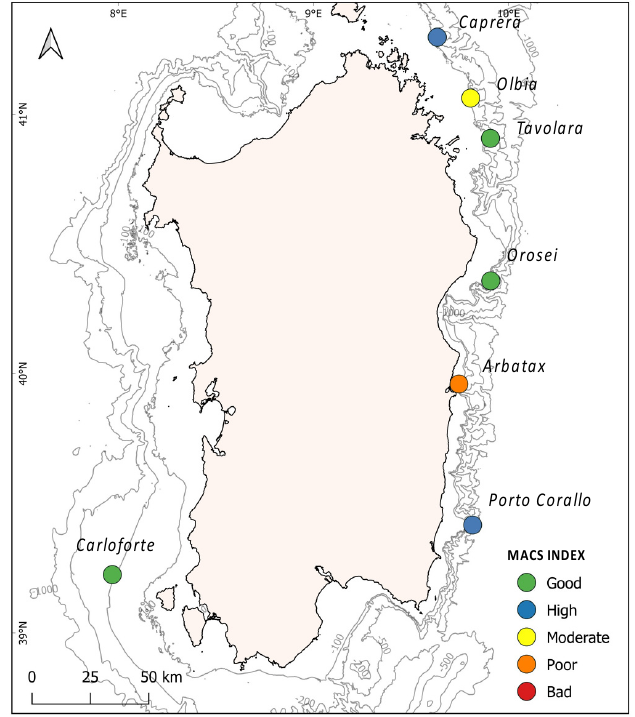
Figure 4. Results of the Index of Status (I s ), Index of Impact (I i ), and MACS Index for the seven investigated sites. Refer to Tables S1 and 1 for site identifications and index results.